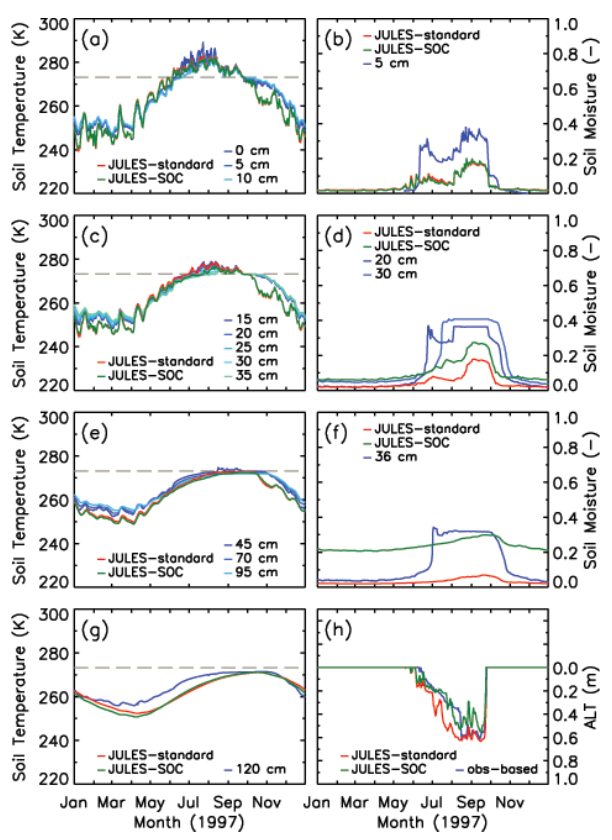
Fig. 9. As Fig. 8 but for Barrow, Alaska in 1997.